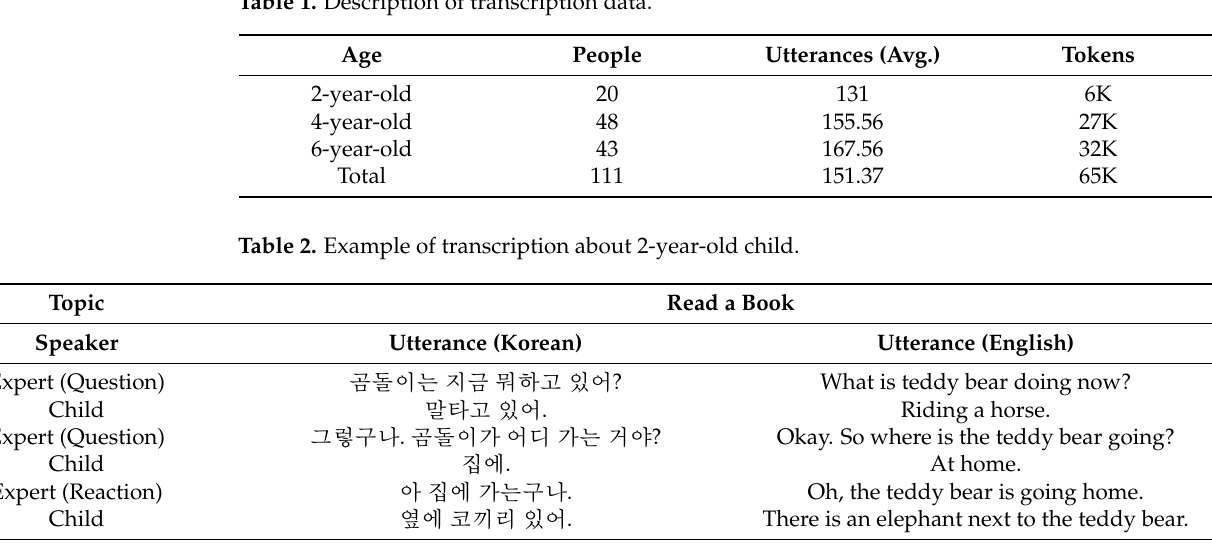
Table 1. Description of transcription data.